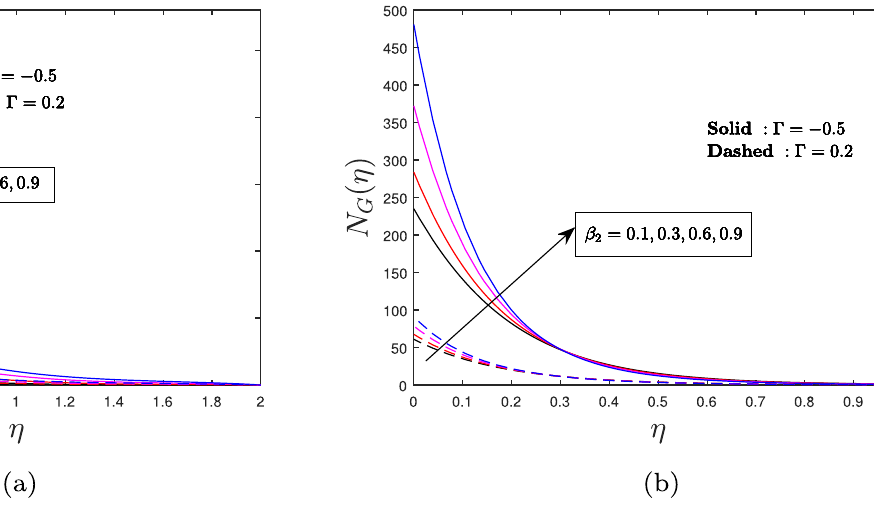
Figure 14: Entropy generation pro fi les against ( a ) β